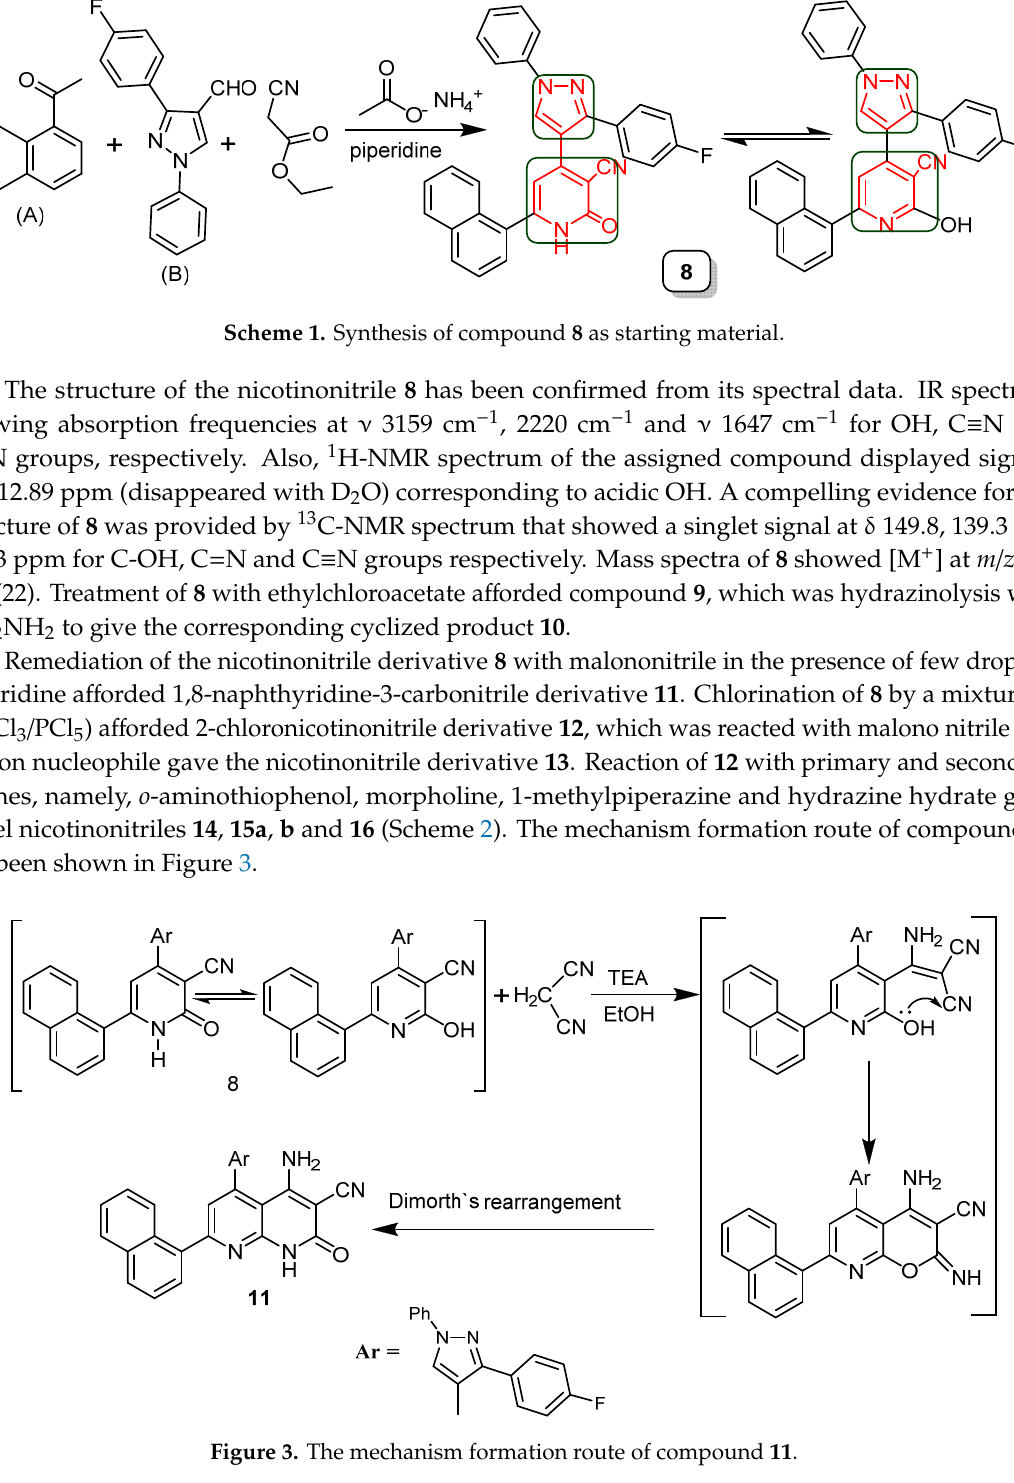
Figure 3. The mechanism formation route of compound 11.